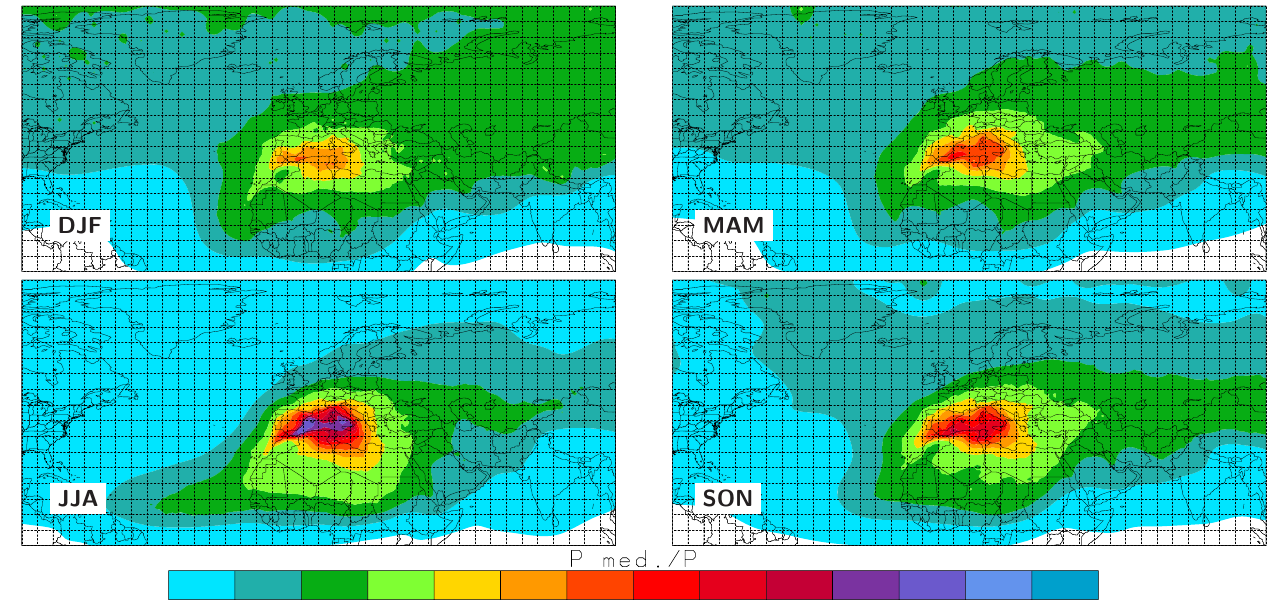
Fig. 13. Same as Fig. 12 (precipitation fraction) but for the western Mediterranean basin.